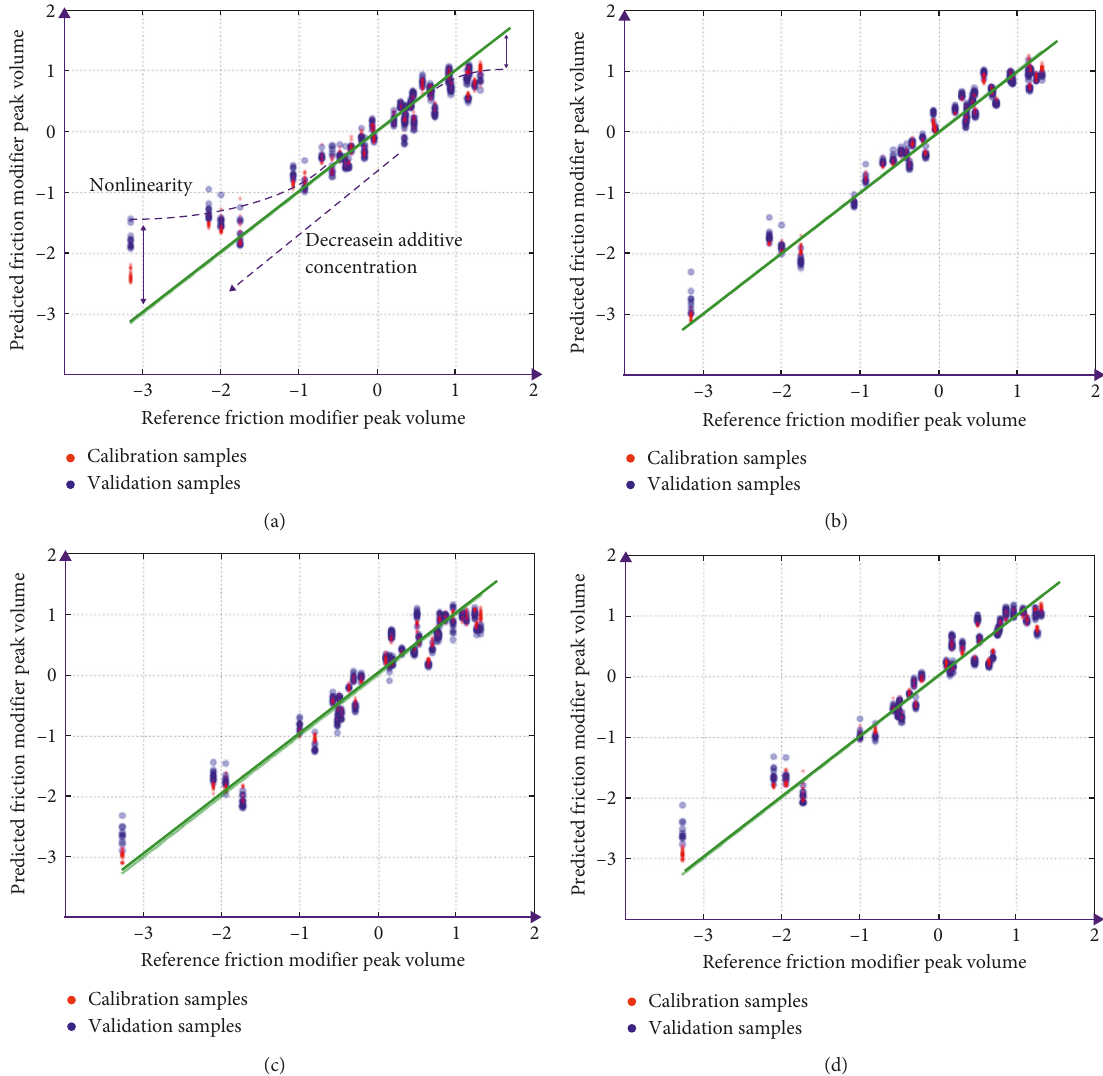
Figure 8: Cross validation results for (a) SNV, (b) Dynamic Localized SNV, (c) Peak SNV, and (d) Partial Peak SNV preprocessed spectra in the regression case of the friction modifier additive. The reference values were measured by HPLC-QToF. Red dots indicate prediction of calibration samples, and blue dots represent prediction of the hold-out validation samples. The dashed arrow in (a) indicates the increasing degradation of the samples with increasing time as the friction modifier additive concentration gets lower.